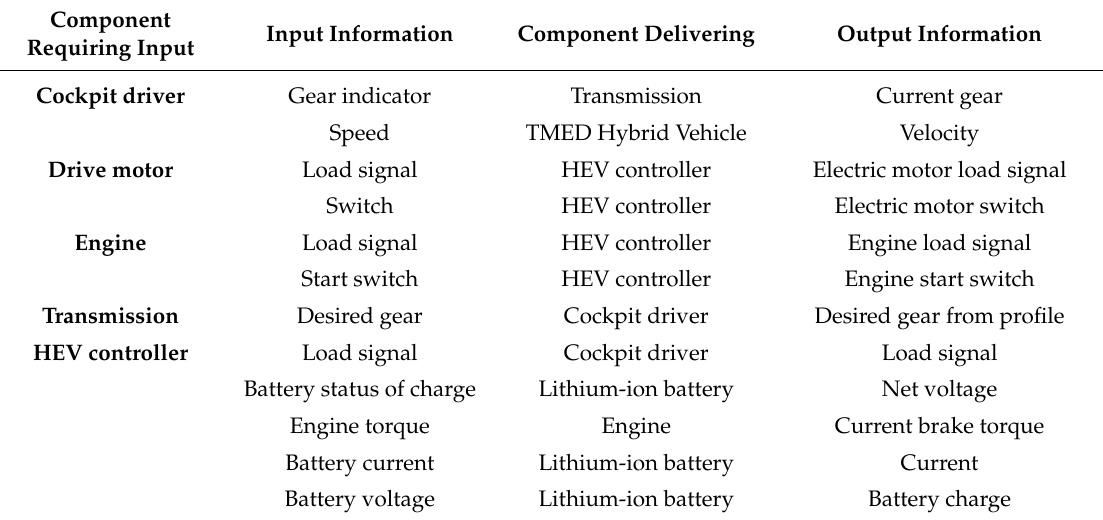
Table 3. Connections between elements on the data